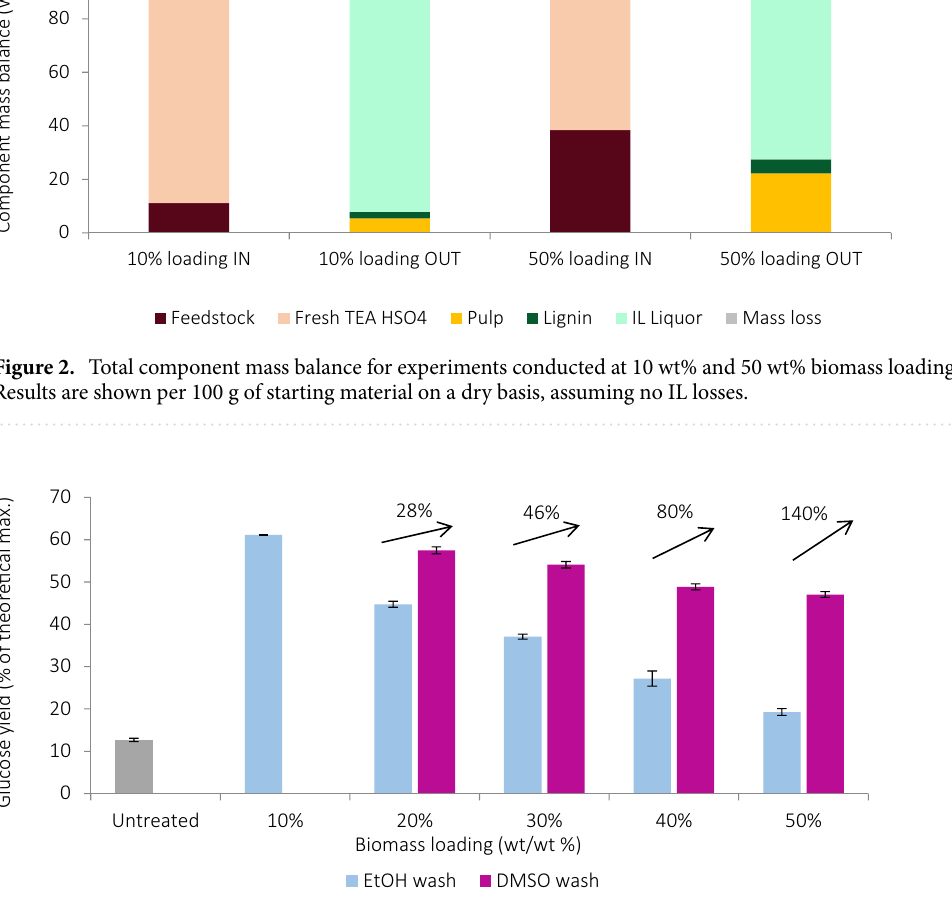
Figure 3. Glucose yields obtained after four ethanol washes (ethanol wash) and four ethanol washes plus one DMSO wash (DMSO wash) of air-dried pretreated Miscanthus pulps at various biomass loadings. Enzymatic hydrolysis was carried out for 7 days and glucose yields are shown relative to the amount of glucan in untreated biomass. Percentage increase following DMSO wash relative to ethanol wash is shown